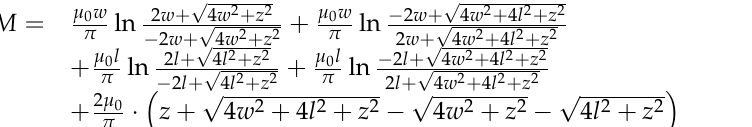
It is assumed that the shape and the size of the primary and secondary coils are the same. In the Figure 4, w 1 = w 2 = w , l 1 = l 2 = l , then the mutual inductance of the single-turn coaxial equal-sized rectangle coil can be calculated by formula (3):